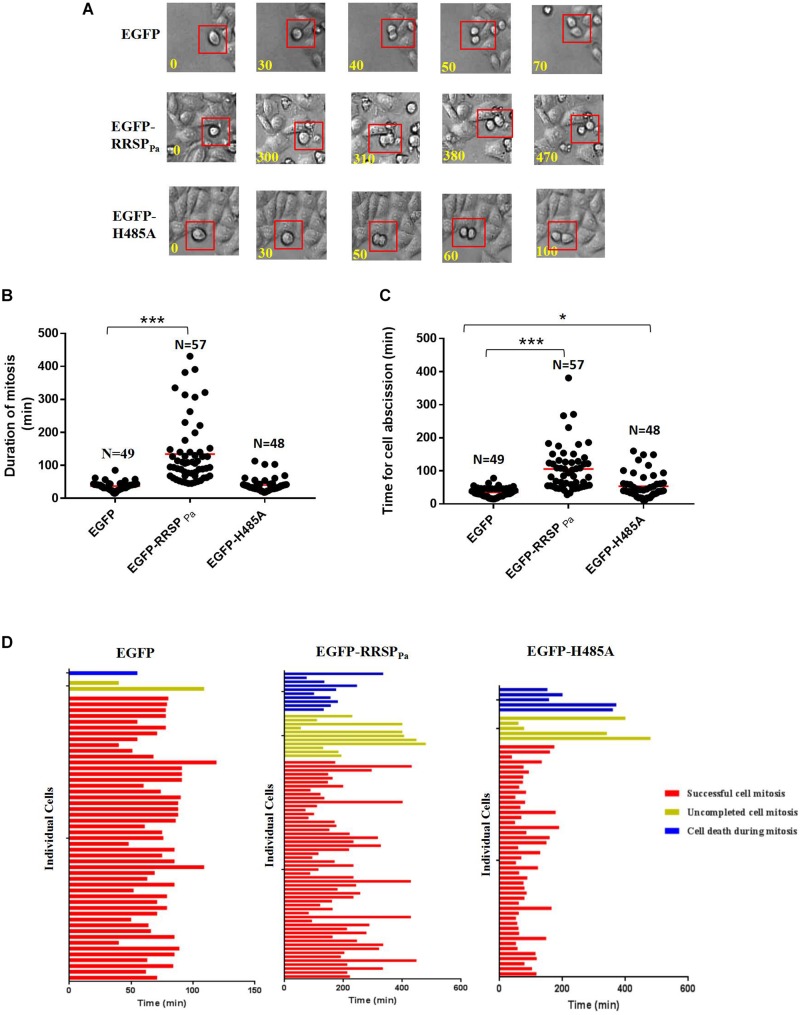
RRSPPa delays completion of cell mitosis and causes cell death during mitosis. HeLa cells were transfected with pEGFP-RRSPPa, pEGFP-H485A, and pEGFP, respectively. 16 h after transfection, cells were monitored with phase-contrast, time-lapse live cell imaging for 8 h. (A) Representative frames from time-lapse series of HeLa cells expressing EGFP (top panel), EGFP-RRSPPa (middle panel), and EGFP-H485A (bottom panel); time was shown in minutes. The time from capturing the first image of a rounding up cell (t = 0 min) to the time of two daughter cells had visibly moved away from each another (ending of cell abscission) was measured. (B) Quantification of the duration of cell mitosis (from cell rounding up to anaphase onset). Time of each individual cell took to undergo mitosis was dotted, the solid red line represented the median time. (C) Quantification of the time for cell abscission (from anaphase onset to the time when the daughter cells separated, indicating the completion of abscission). Time of each individual cell took to undergo cell abscission was dotted, the solid red line represented the median time. (D) Fate profiles of cells entering mitosis that underwent successful mitosis, cell death, and incomplete cell mitosis. Each horizontal bar represented a single cell, and the color of the bar denoted the fate of the cell. The red bars indicated that the cells underwent successful cell mitosis, the yellow bar indicated uncompleted cell mitosis, and the blue bar indicated cell death during mitosis. The length of the bars denoted the duration of each cell fate. The length of red bar indicated the duration of time from cell rounding up to the completion of abscission. Time was shown in minutes. N representing the number of cells counted in this experiment. The experiments were repeated three times; at least three individual images in each replicate were taken for counting. t-test was used for statistical analysis. ***P < 0.001; *P < 0.05; ns, no significance.